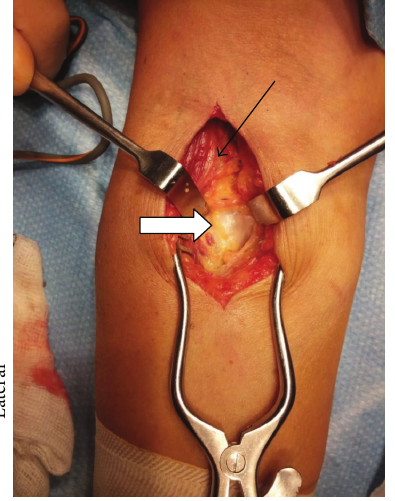
Figure 5: Cubital fossa approach with exposure of bicipitoradial bursa (white arrow). Bicep tendon (thin arrow).